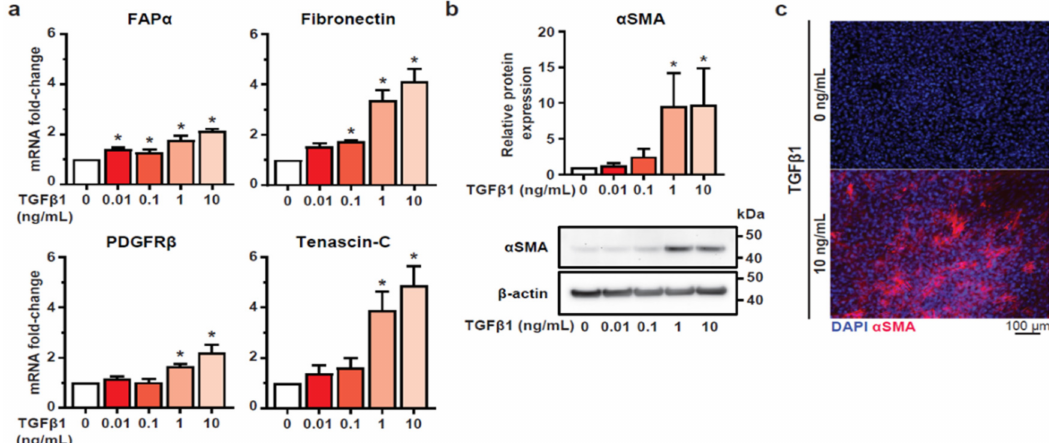
Figure 1. Cancer associated fibroblast (CAF) marker expression in transforming growth factor beta 1 (TGF β 1) treated HMF3S cells. Serum starved HMF3S cells were stimulated with either TGF β 1 (0.01, 0.1, 1, or 10 ng/mL) or vehicle control (0 ng/mL) for 48 h prior to assessing marker. ( a ) TGF β 1 treatment increased mRNA levels of CAF-associated genes fibroblast activation protein- α (FAP α ), platelet-derived growth factor receptor- β (PDGFR β ), fibronectin and tenascin-C compared with vehicle at the indicated concentrations. ( b ) Representative immunoblot and densitometry showing significant induction of α -smooth muscle actin ( α SMA) protein compared with vehicle at 1 and 10 ng/mL TGF β 1. ( c ) Representative immunofluorescence images showing an upregulation of α SMA protein (red) compared with vehicle control. Nuclear (DAPI) staining is also indicated (blue). ( a , b ) Data are represented as means ± SD from three independent experiments; * p < 0.05 from post-hoc Dunnett’s multiple comparison test after one-way ANOVA revealed significant effect of